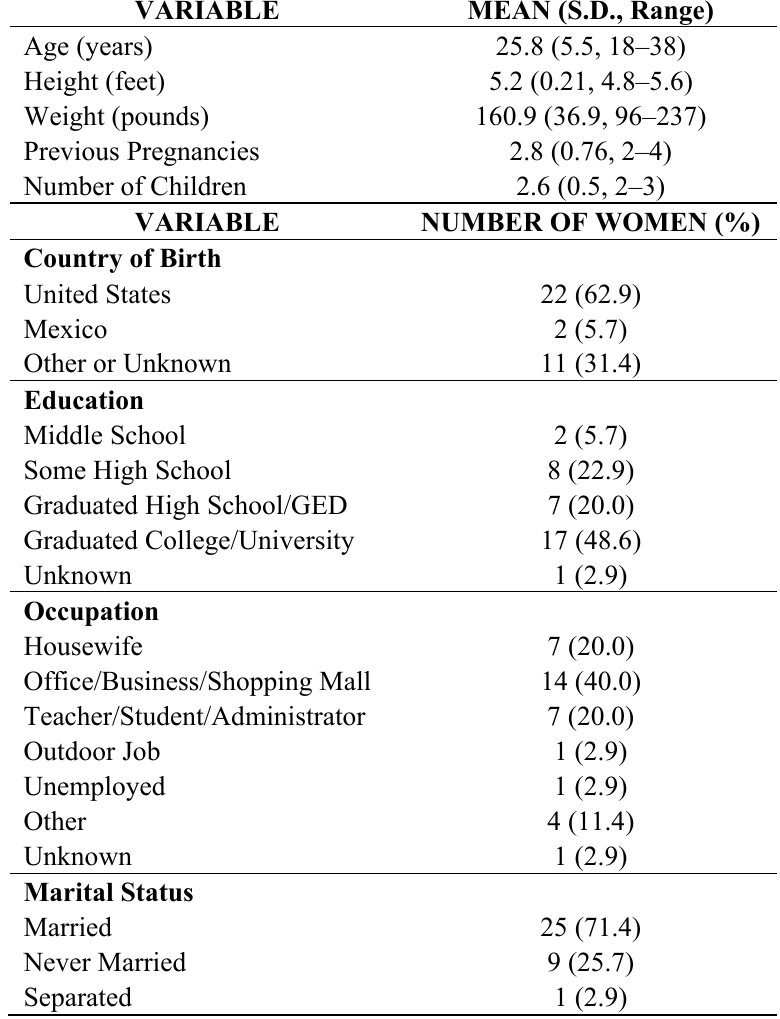
Table 1. Sociodemographic attributes of women participating in the study (N = 35).